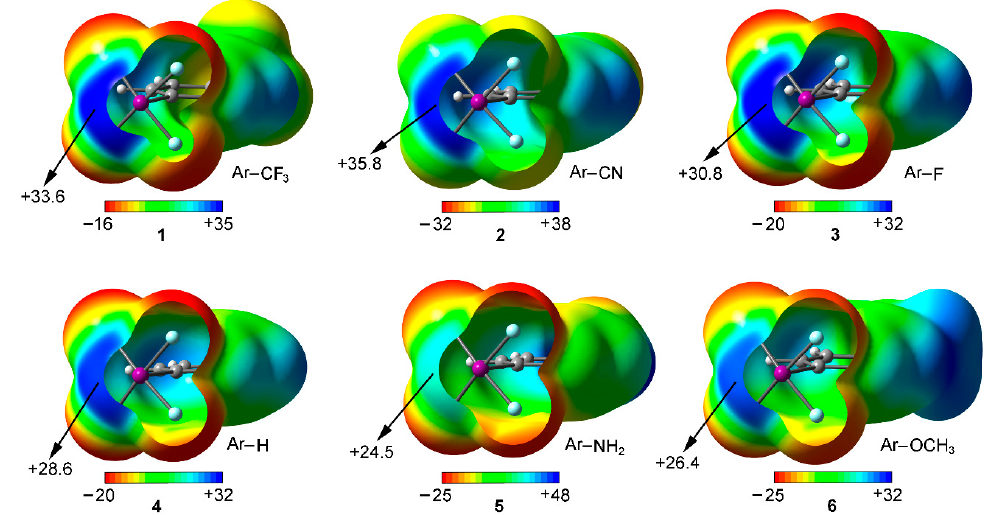
Figure 2. MEP surfaces of Compounds 1 to 6 used in the study. Energies at selected points of the surface (0.001 a.u.) are given in kcal/mol. surface (0.001 a.u.) are given in